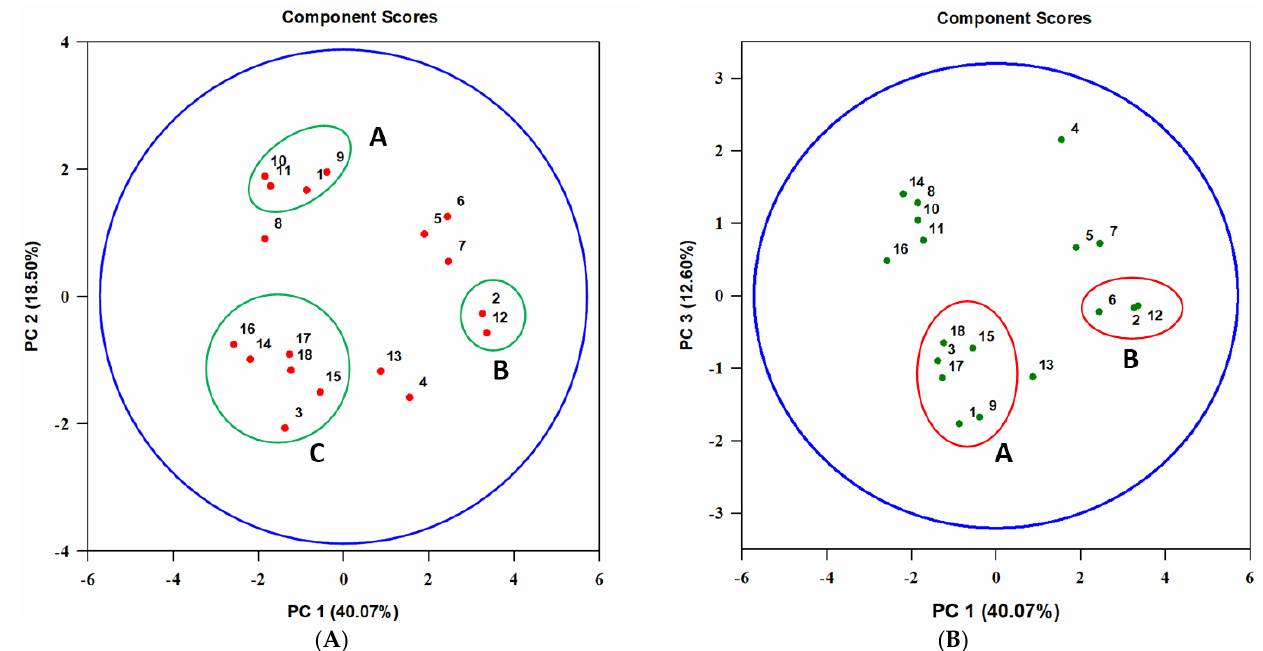
Figure 7. Principal component (PC) analysis ( A ) – PC1 vs. PC2, ( B ) – PC1 vs. PC3 on the relationship between the sensi- tivity of various organisms to different A. tenuissima MFP253011 extracts and the contents of major metabolites in them. Test organisms: 1 — Schizaphis graminum , 2 — Galleria mellonella , 3 —Sf9 cell line, 4 — Raphanus sativus , 5 — Triticum aestivum ,